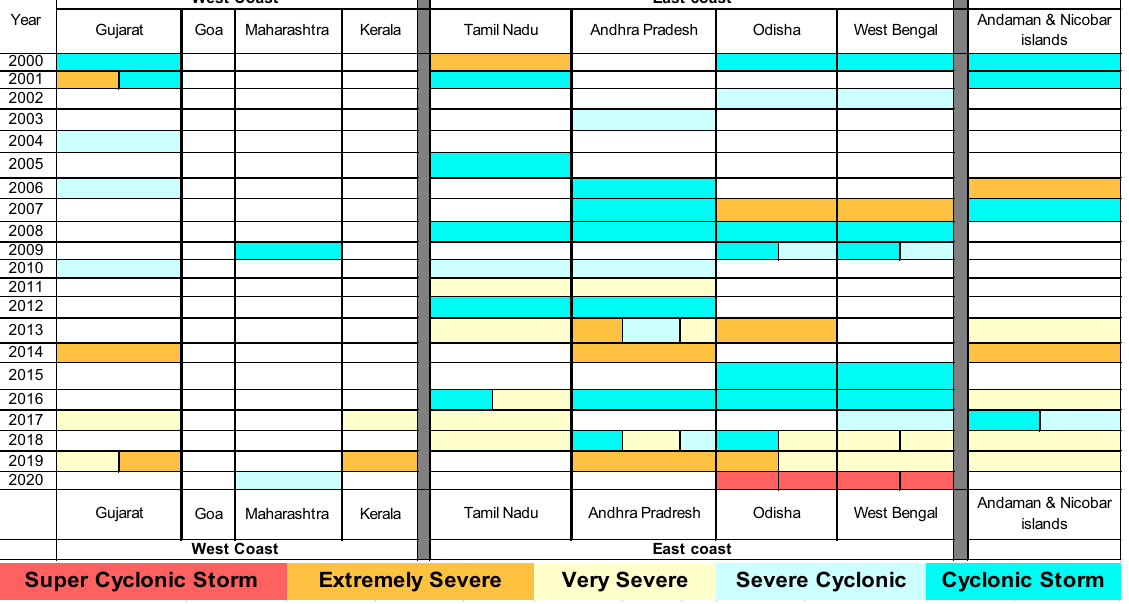
Table 1. Time series of tropical storms across the east and west coast of India, including the Andaman Islands, compiled from data available through the Indian Metrological Department (IMD). The colours represent the intensities of the cyclones in a given year. It does not, however, provide insight on the frequency of storms for any given year. Super Cyclonic Storm = Category 5; Extremely Severe = Category 4; Very Severe = Category 3; Severe Cyclonic = Category 2; and Cyclonic Storm = Category